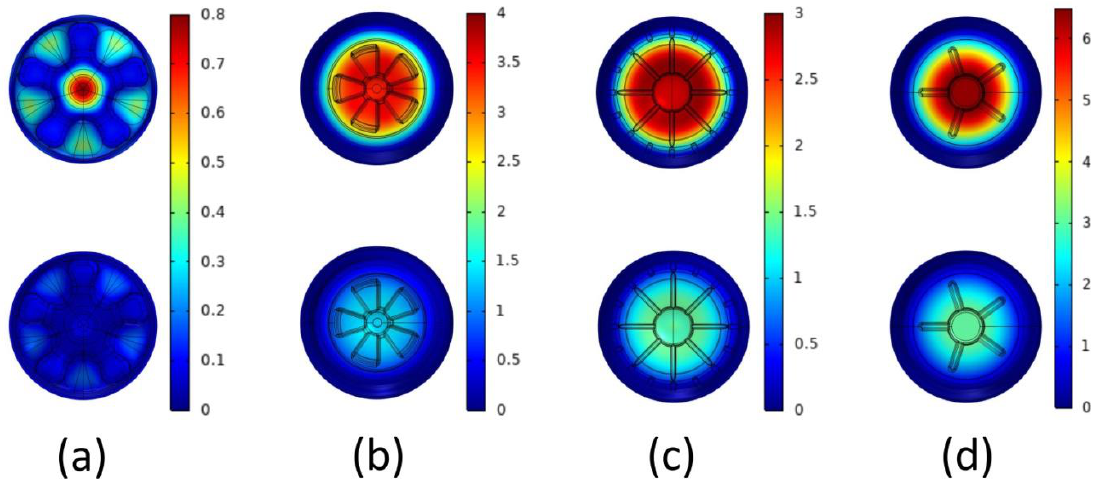
Figure 5. The deformation diagram of CF-bottom ( a ), PP-bottom ( b ), PR-bottom ( c ), and OR-bottom ( d ) before and after optimization (mm).